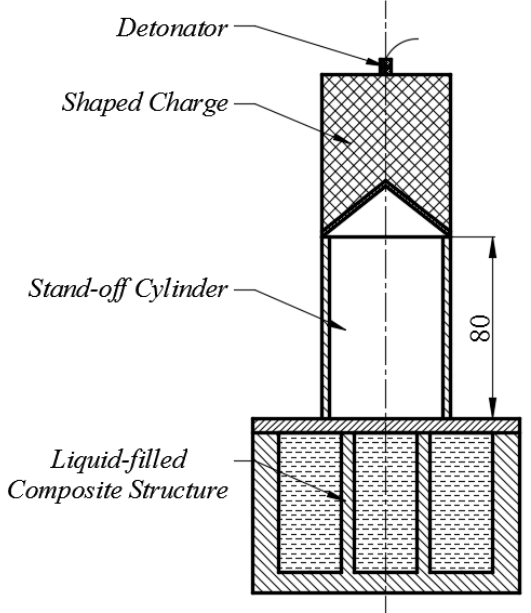
Figure 16. Schematic of the interaction between projectile and target.